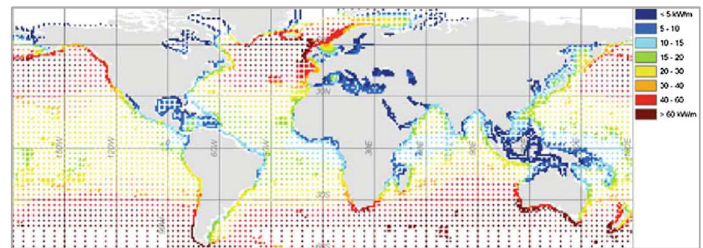
Figure 2. Annual global gross theoretical wave power for all World Waves grid points. Figure from [19].